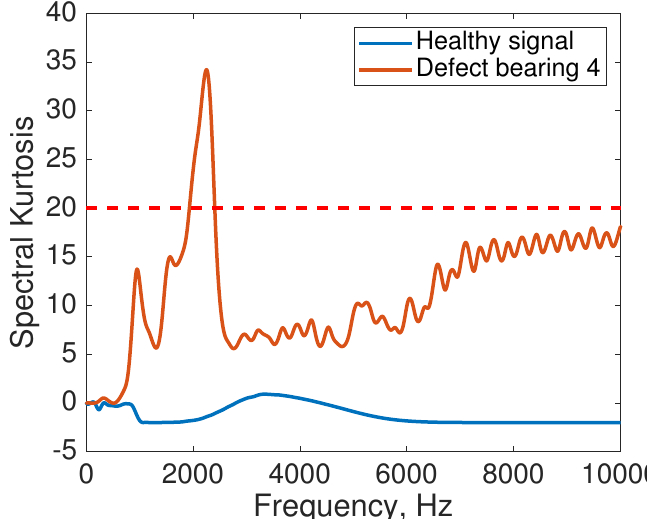
Figure 7. Spectral Kurtosis Estimate for signal 10 and 2100, healthy and